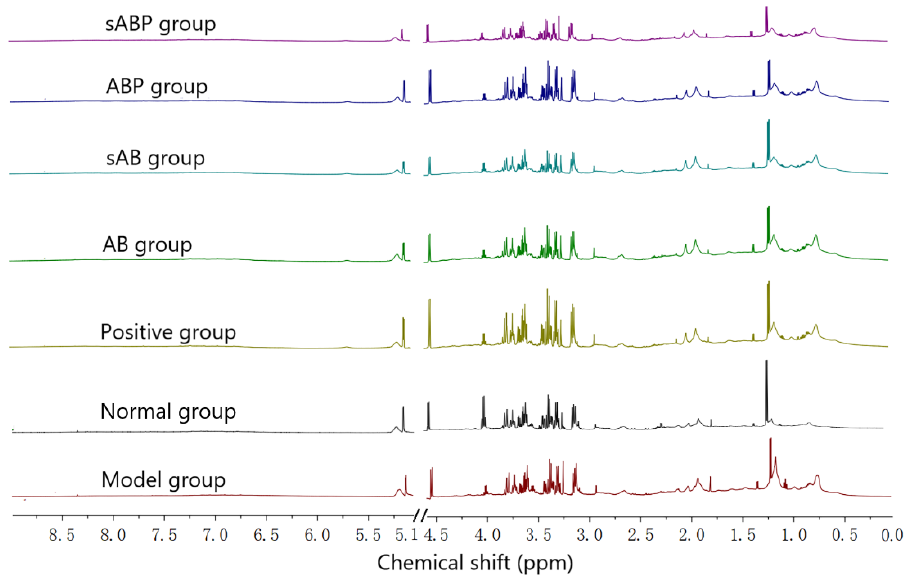
Figure 4. Representative NMR spectra of serum samples from normal group, model group, and differently treated groups.